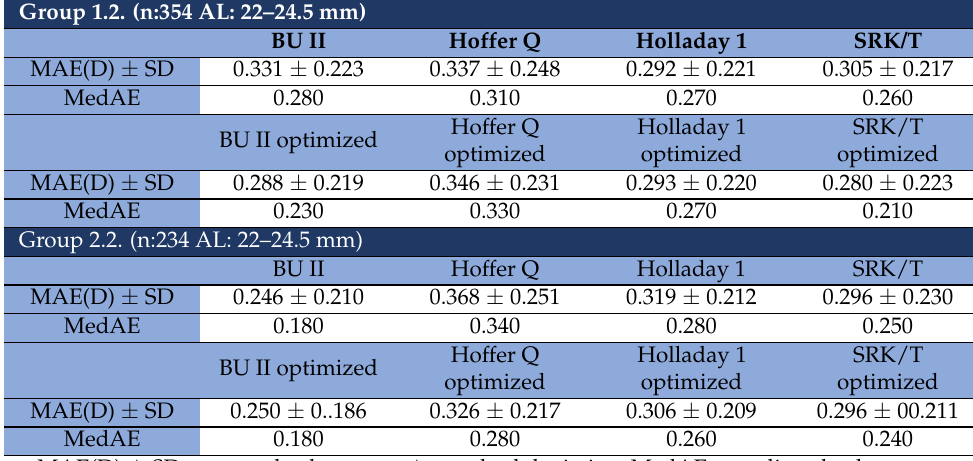
Table 8. Prediction errors for groups with AL 22–24.5 mm. Group 1.2. (n:354 AL: 22–24.5 mm)